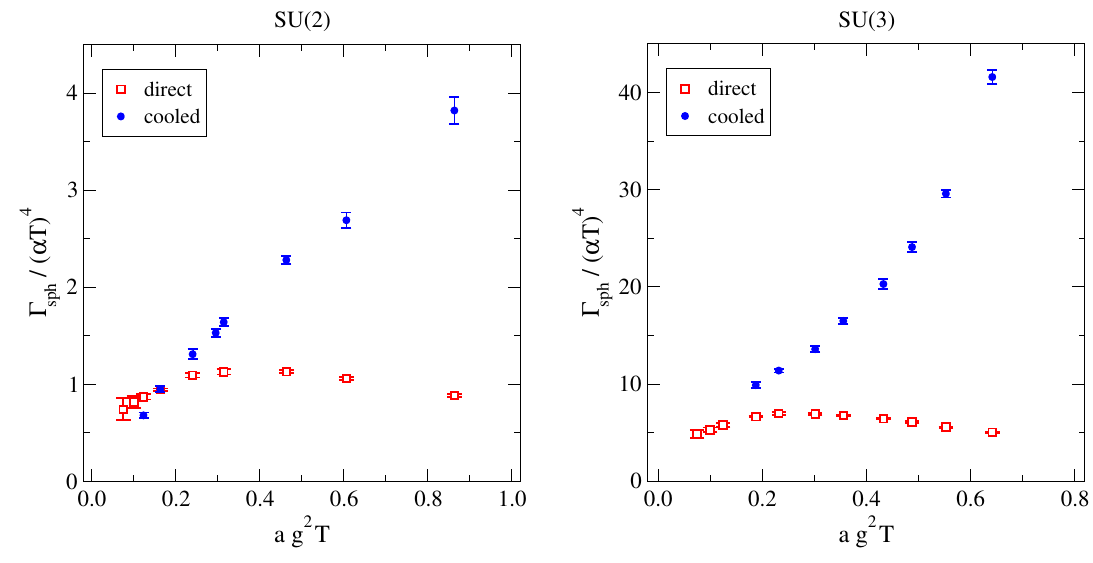
Figure 3 . Comparison of our Γ from eq. (5.1) (“direct”) against literature results employing a sph different definition (“cooled”) [10, 25]. The data are as given in tables 1 and 2, with errors combined in quadrature. The results do not agree quantitatively, but both approach zero in the scaling regime ag 2 T (cid:28) 0 . 2 , with an approximately linear slope, modified by a complicated logarithmic